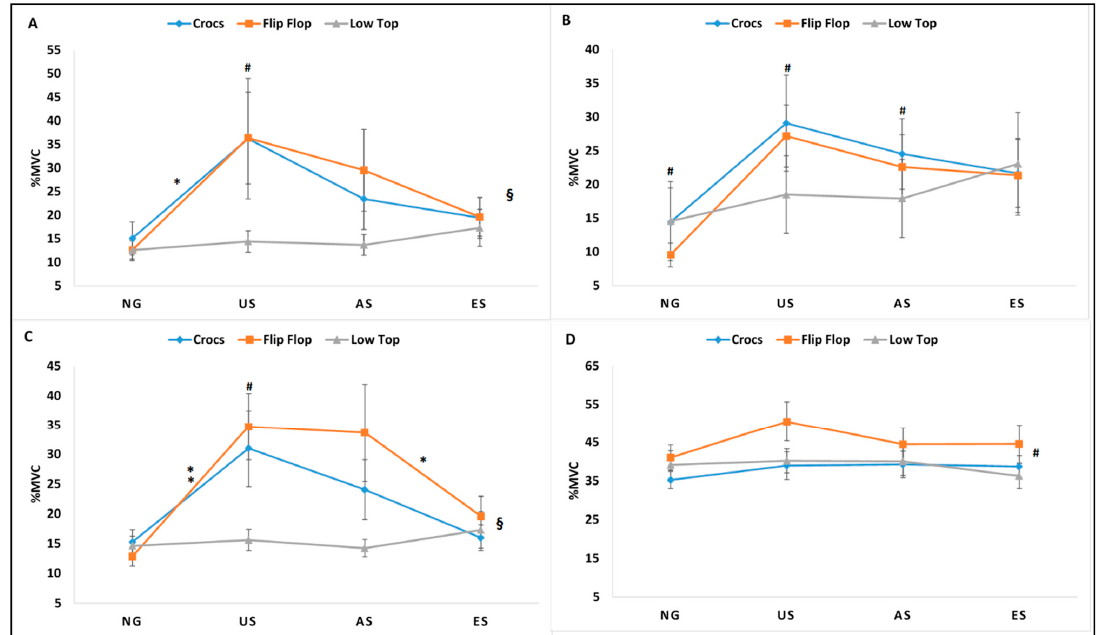
Figure 6. %MVC muscle activity for vastus medialis ( A ), medial hamstrings ( B ), tibialis anterior ( C ), and medial gastrocnemius ( D ) during stance phase for Crocs, flip-flops, and low top slip resistant shoe during normal gait (NG), unexpected slip (US), alert slip (AS), and expected slip (ES) events. § denotes significant interaction between footwear type and gait/slip trial; * denotes significant difference for footwear across gait trials and # denotes the significant difference for gait trials across footwear. All differences were significant at the alpha level p < 0.05.